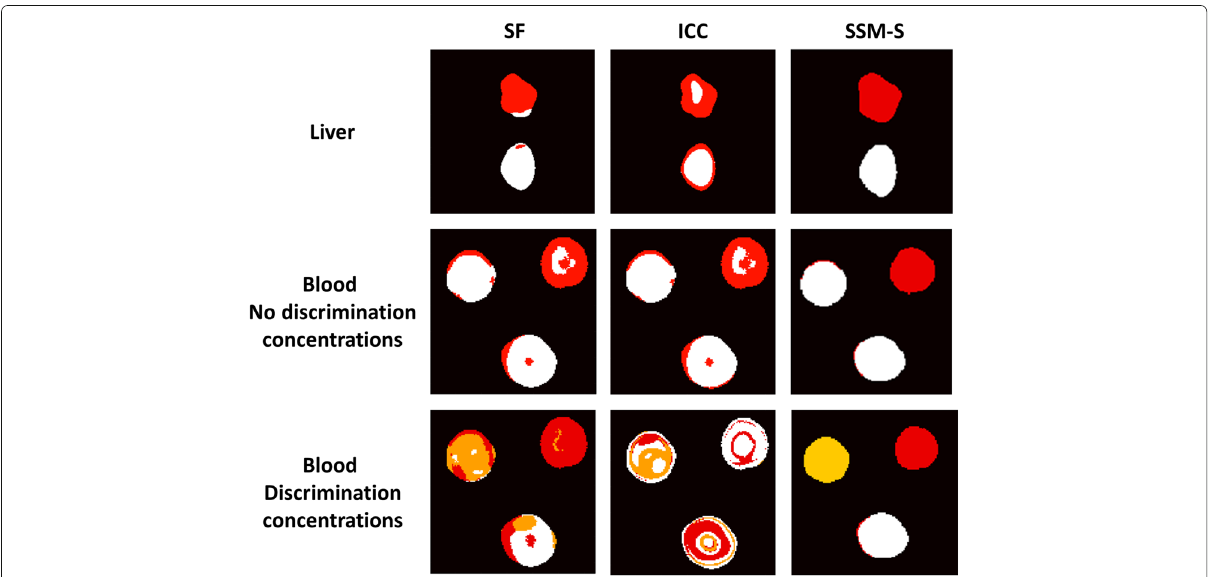
Fig. 10 Comparisons. Resulting maps for the two datasets and the different desired applications using spectral fitting (SF) [7], intra-class correlation (ICC) [9, 10], and the spatio-spectral mean-shift (SSM-S) algorithm, as